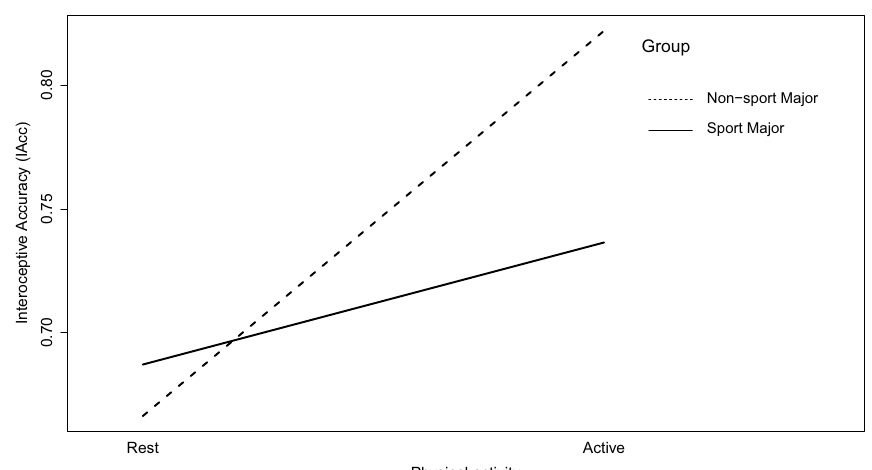
Figure 3. Interaction plot displaying the difference in interoceptive accuracy (IAcc) scores between active and rest conditions, with participants grouped by sporting background (students majoring in sport [ N = 24] vs non- sport focussed courses [ N = 24]).